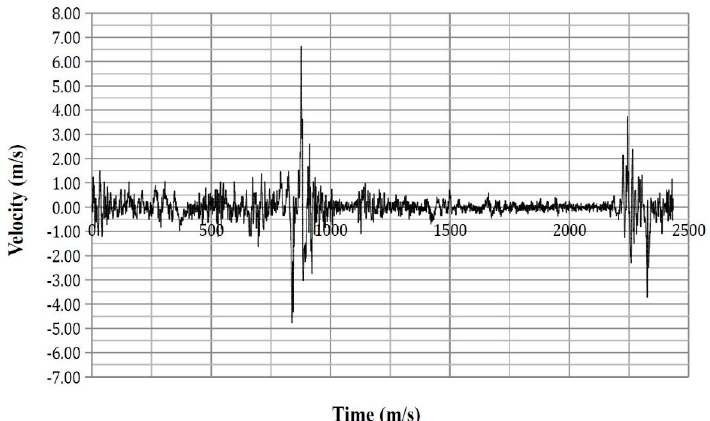
Figure A23. ATD Position 2 y-axis velocity for Node 380823.